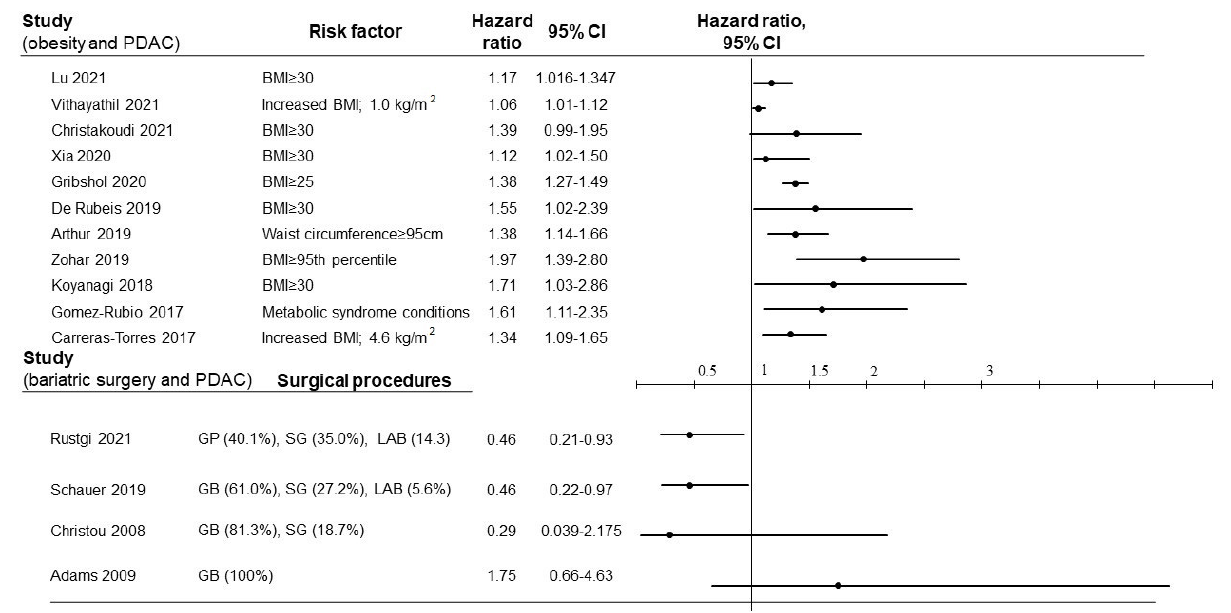
Figure 2. Summary of hazard ratio (HR) for pancreatic ductal adenocarcinoma (PDAC) incidence associated with obesity (above) and bariatric surgery (below). For each plot, the black circle represents the study-specific HR, and the arms of each symbol denote the 95% confidence intervals (95% CI). GB: Gastric bypass, SG: Sleeve gastrectomy, LAB: Laparoscopic adjustable band.